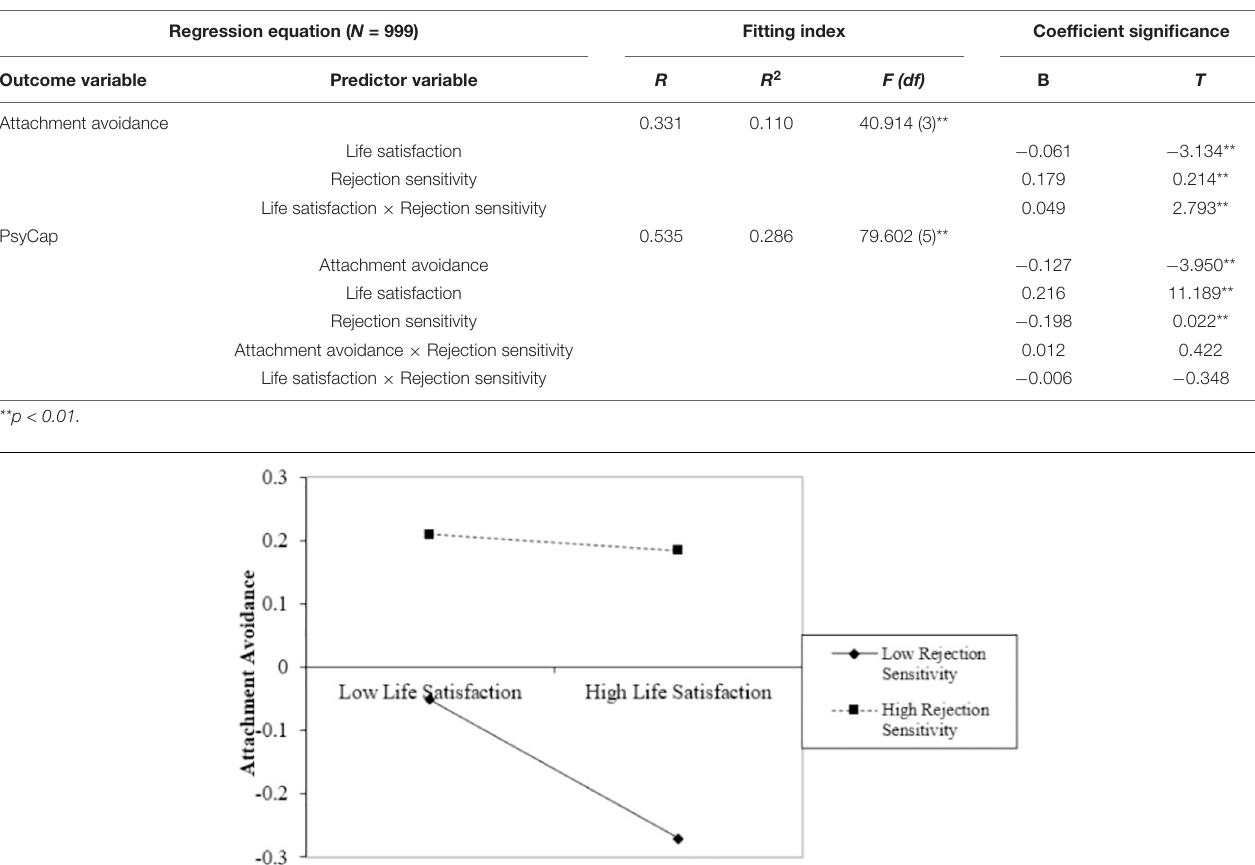
TABLE 4 | The moderated mediation model analysis.